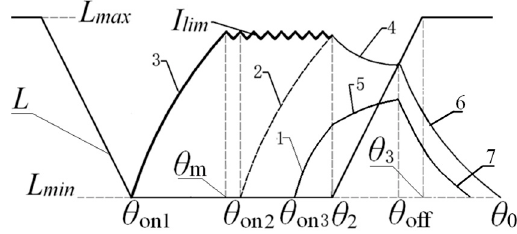
Figure 3. Current waveforms at different turn-on angles.